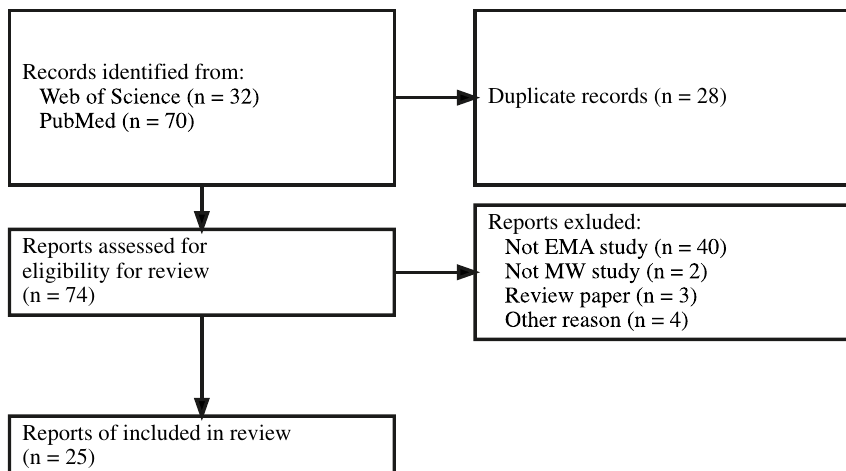
Figure 1. Flow chart of the study selection